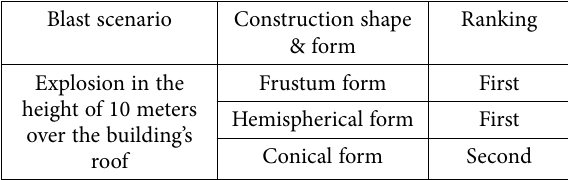
Table 4. Ranking of the building form by the scenario of explosion in the height of 10 meters over the building’s roof